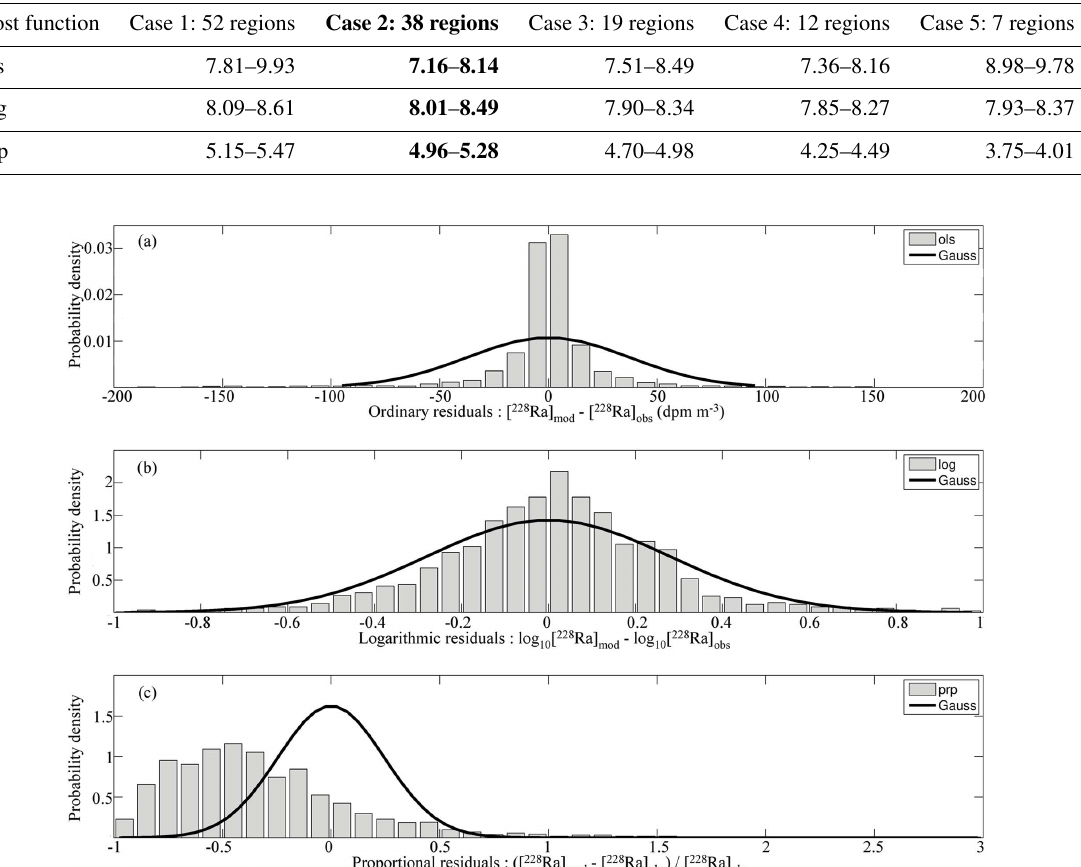
Figure 7. Probability density functions (PDFs) of 228 Ra (a) ordinary residuals, (b) logarithmic residuals and (c) proportional residuals after inversion, compared with a Gaussian PDF (black full line) based on their standard deviations.